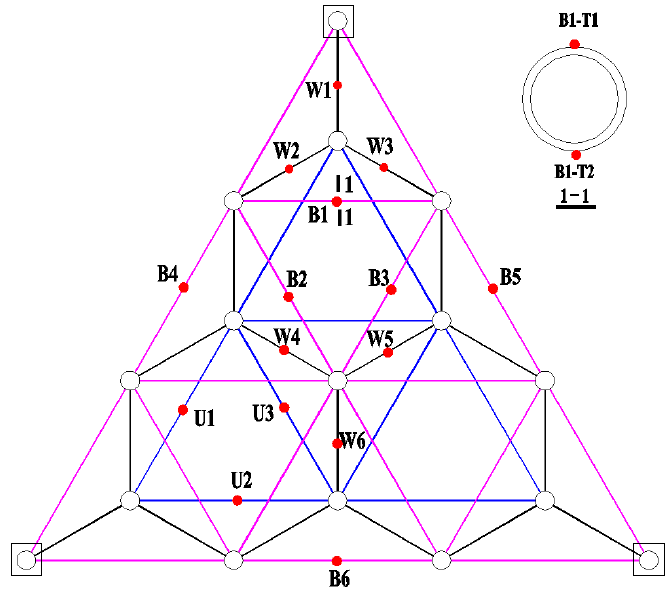
Figure 2. The arrangement of the measuring points of the test model. Black boxes indicate the cross plate supports.